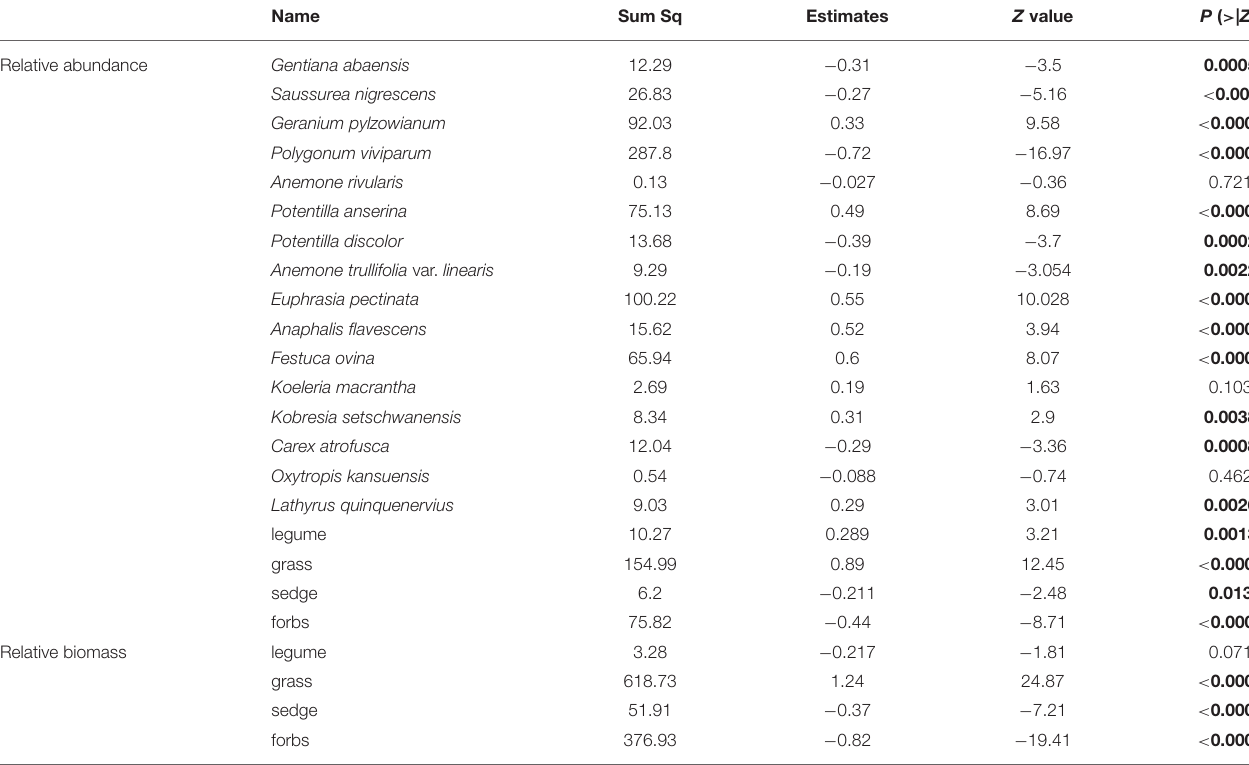
TABLE 2 | Summary of the GLMMs showing the warming effect on the relative abundance and biomass of 16 species and four functional